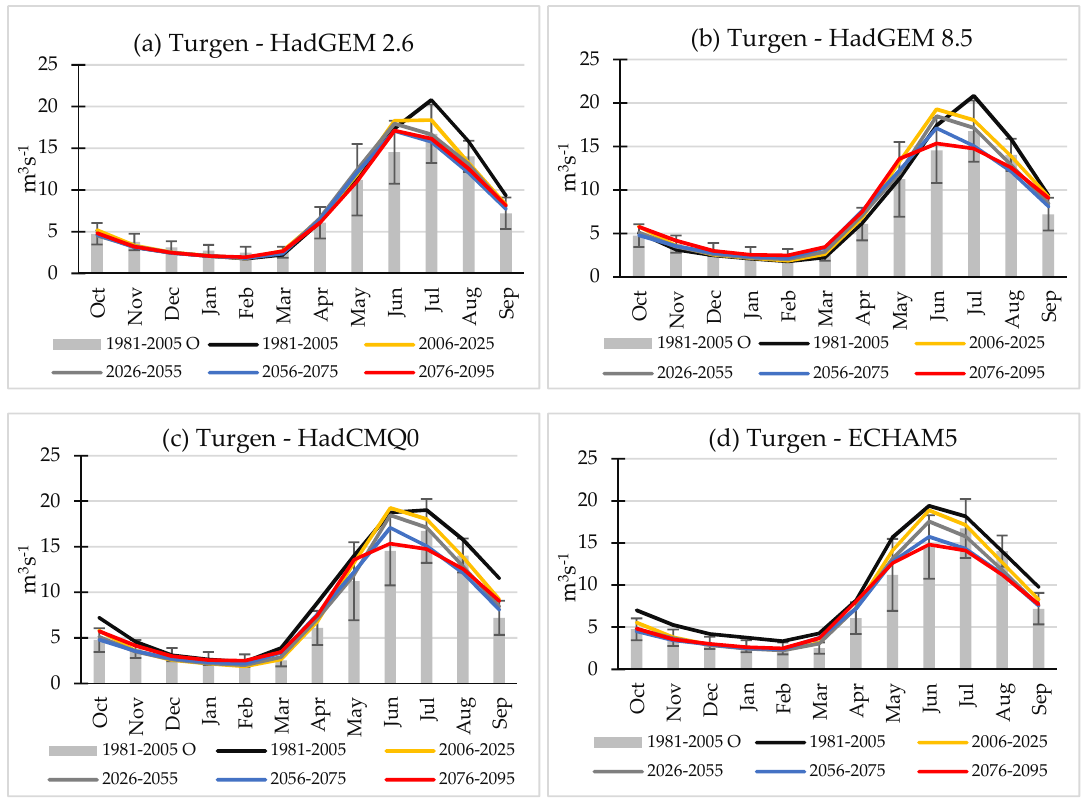
Figure 15. As in Figure 12 but for the Kaskelen.